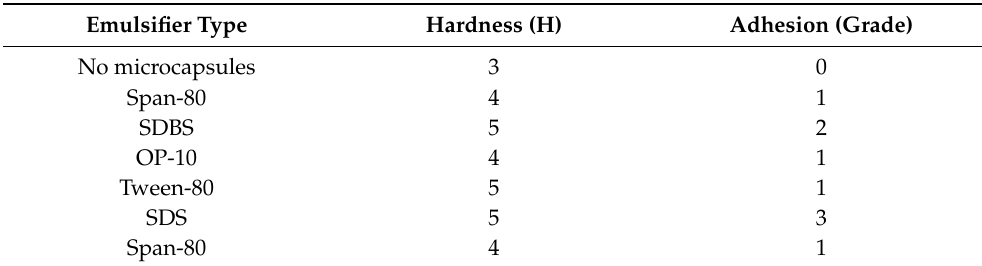
Table 6. Effect of emulsifier on film hardness and adhesion.